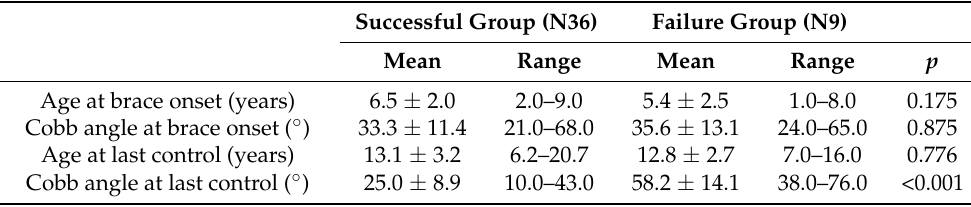
Table 1. Cobb evolution in both successful and failure groups (significance p < 0.05).